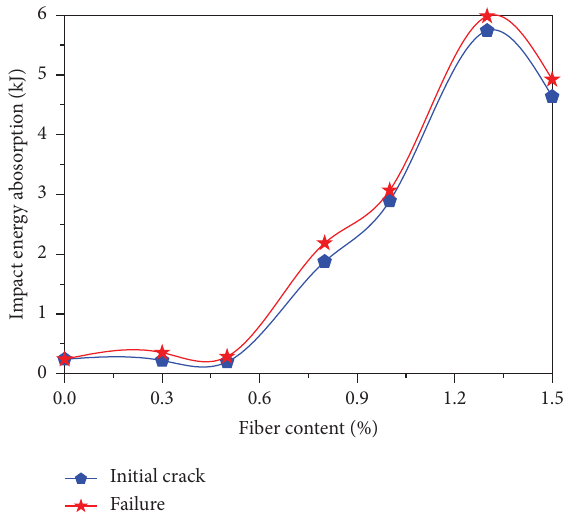
Figure 10: ARGFRC impact energy absorption.